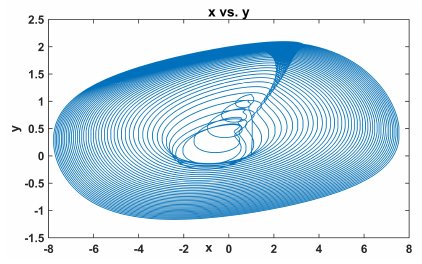
Figure 27. Responses of membrane potential with parameter values a = 0.7, b = 1.5, c = 3